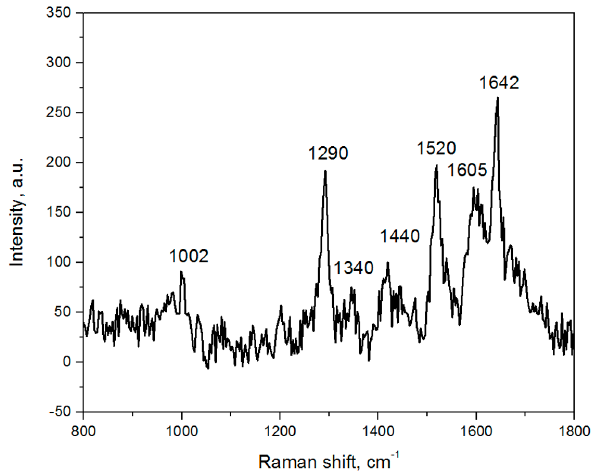
Figure 11. SERS spectrum of the lactoferrin molecules adsorbed on the silvered por -Si from 10 − 18 M solution and then protected with graphene.